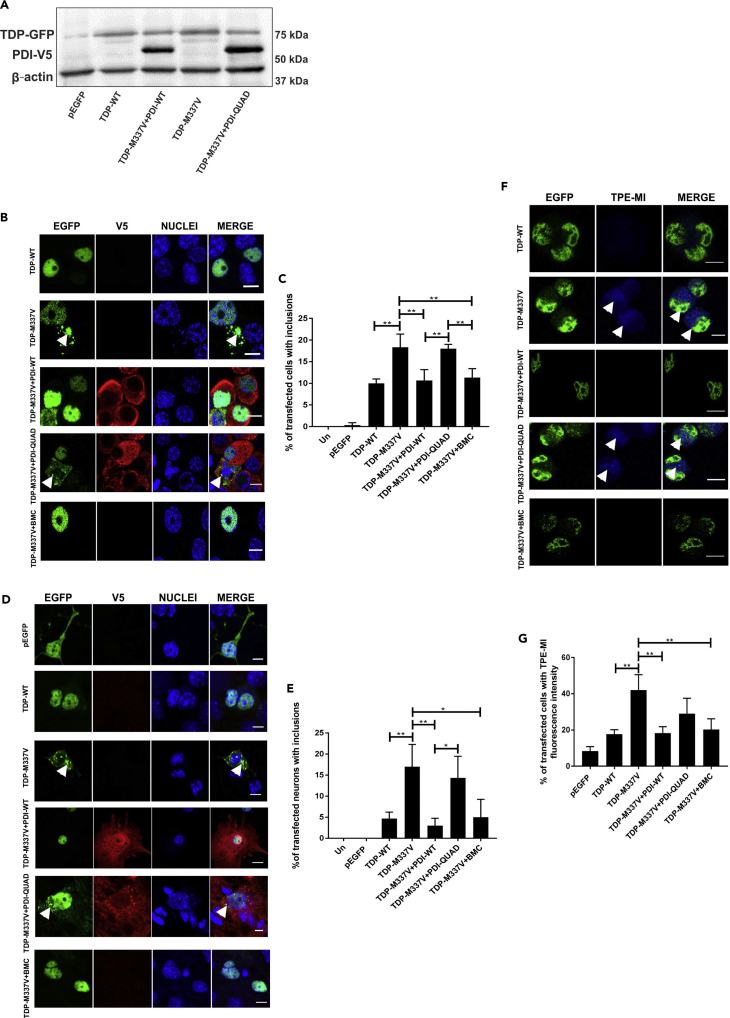
The Oxidoreductase Activity of PDI Is Protective against Inclusion Formation and Protein Unfolding in Mutant TDP-43 Expressing Cells.(A) Immunoblotting was performed to confirm that similar transfection efficiencies were present and that co-expression of PDI-WT or PDI-QUAD did not alter the expression of TDP-43 EGFP. An anti-TDP-43 antibody was used to detect the presence of wild-type TDP-43 (TDP-WT) or mutant TDP-43M337V (TDP-M337V), in cells co-expressing either empty vector pcDNA3.1 or PDI-V5 (WT or QUAD), β-actin was used as a loading control.(B) Immunofluorescence detection of EGFP in cells expressing EGFP-tagged TDP-WT (row 1), TDP-M337V with empty vector alone (row 2) or co-expressing PDI-WT or PDI-QUAD, or administered with BMC (rows 3, 4, 5).(C) Significantly fewer cells formed inclusions when PDI-WT was co-expressed with TDP-M337V or treated with BMC (∗∗p < 0.01). Significant differences were observed between TDP-M337V cells co-expressing PDI-WT or PDI-QUAD, and TDP-M337V cells co-expressing PDI-QUAD or BMC (∗∗p < 0.01).(D) Neurons expressing EGFP only (row 1), TDP-WT (row 2), TDP-M337V alone (row 3), or co-expressing PDI-WT or PDI-QUAD, or BMC-treated (rows 4, 5, 6).(E) Significantly fewer cells formed inclusions when PDI-WT was co-expressed with TDP-M337V (∗∗p < 0.01) and treated with BMC (∗p < 0.05). Significant differences were observed between TDP-M337V cells co-expressing PDI-WT or PDI-QUAD (∗p < 0.05).(F) TPE-MI fluorescence in Neuro-2a cells expressing TDP-WT (row 1), TDP-M337V with empty vector alone (row 2), or co-expressing PDI-WT or PDI-QUAD, or treated with BMC (rows 3, 4, 5), arrows represent TPE-MI fluorescence.(G) Significantly fewer cells displayed TPE-MI fluorescence (representing the cellular load of unfolded proteins, blue) when PDI-WT was co-expressed with TDP-M337V or cells were treated with BMC (∗∗p < 0.01) compared to controls.Scale bars: 8 μm in (B), 5 μm in (D), 12 μm in (F).